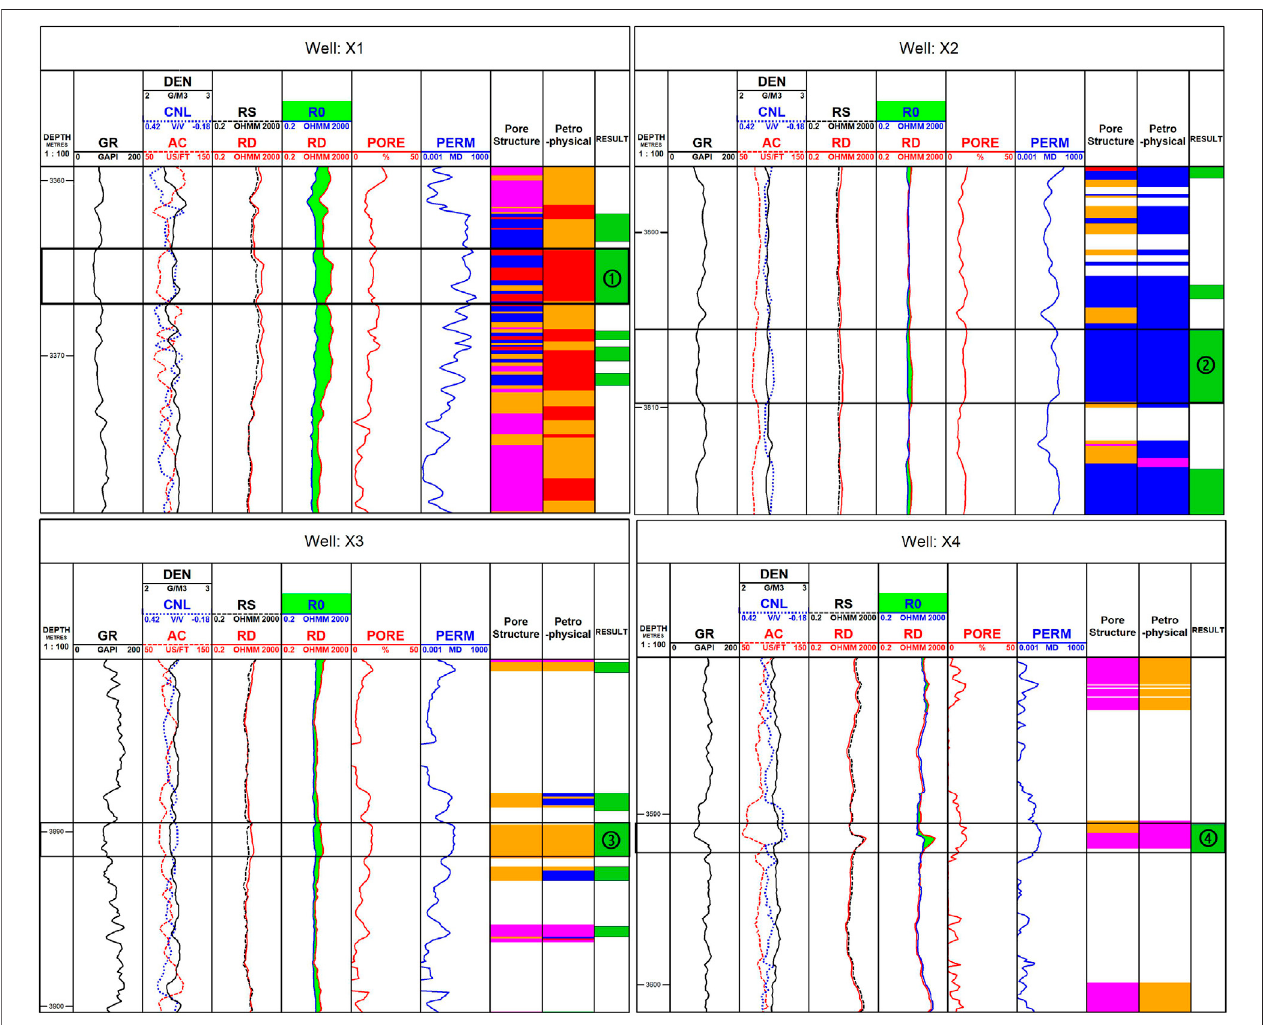
FIGURE 9 | Results plot of different petrophysical facies of the Es 3 reservoir.